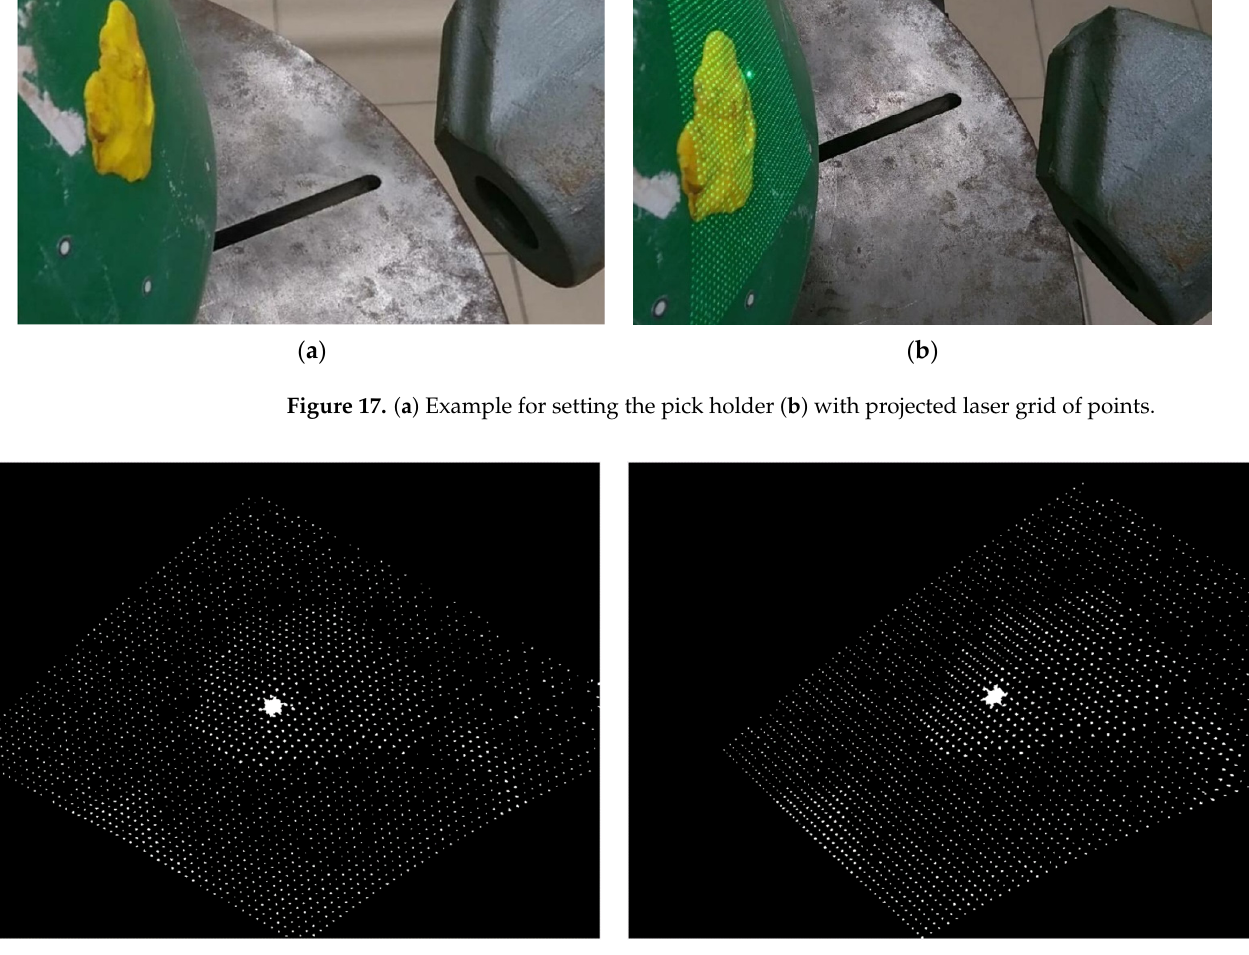
Figure 19. Scanning grids of the cutting head side surface and pick holder, imported into GOM Inspect Professional (GOM GmbH, Braunschweig, Germany).